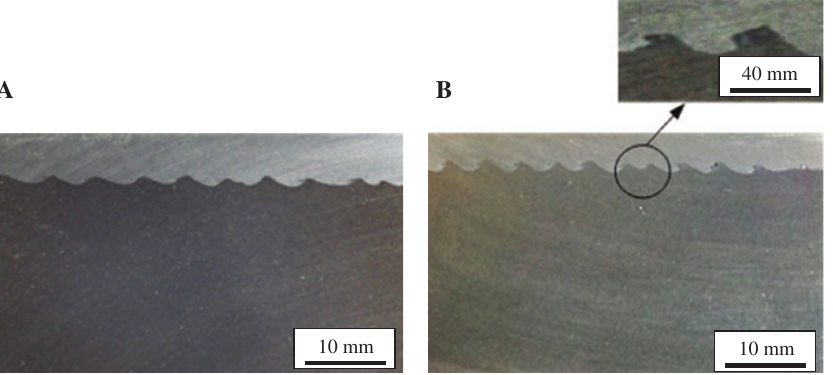
Figure 3: Macroscopic interfaces after explosive welding at 2500–3000 m/s denotation velocity – 4-mm 6061Al alloy flyer plate and 20-mm AZ31B Mg alloy base plate. (A) Earlier stage of the interface; (B) later stage of the